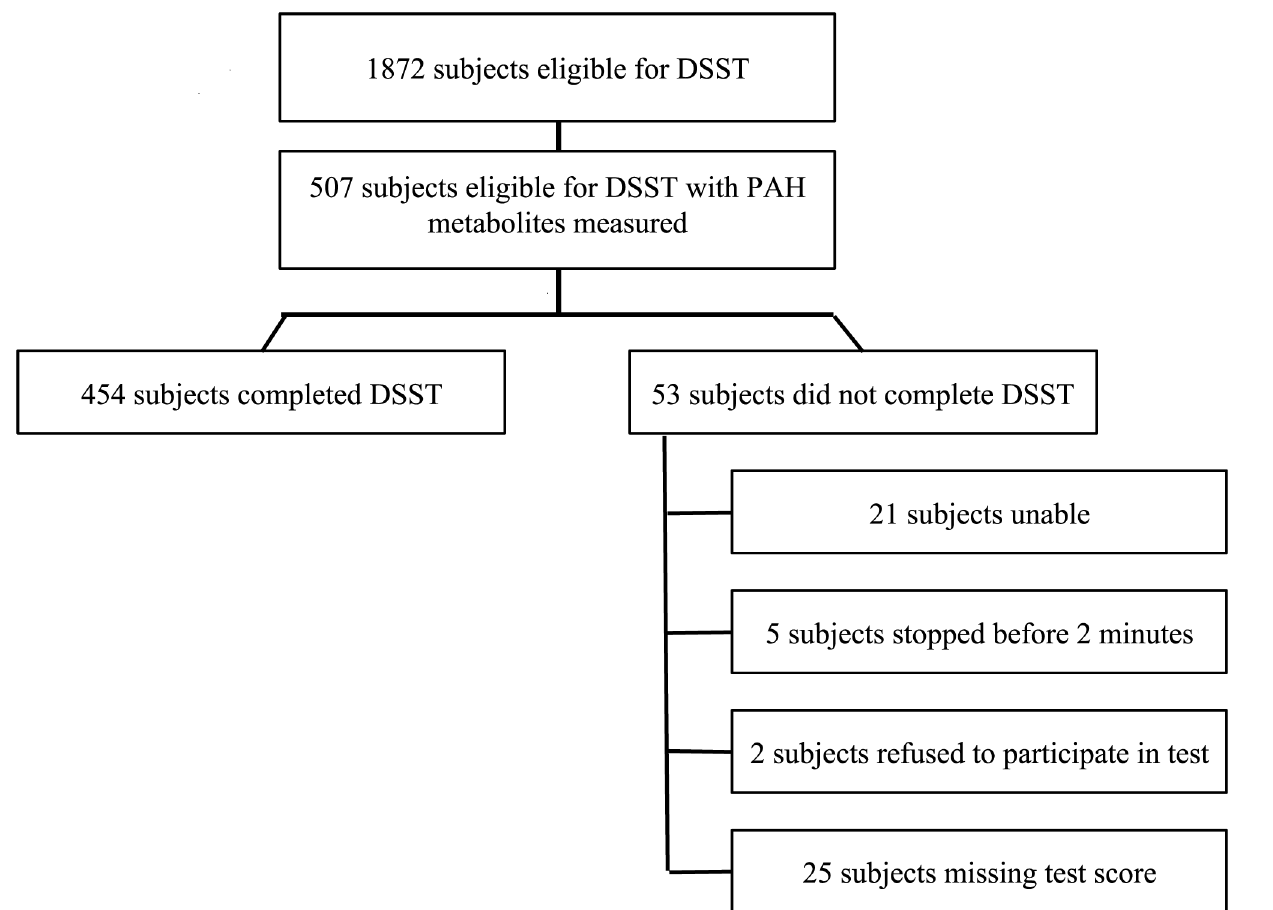
Fig 1. Flow Diagram of the Total Eligible Population and Study